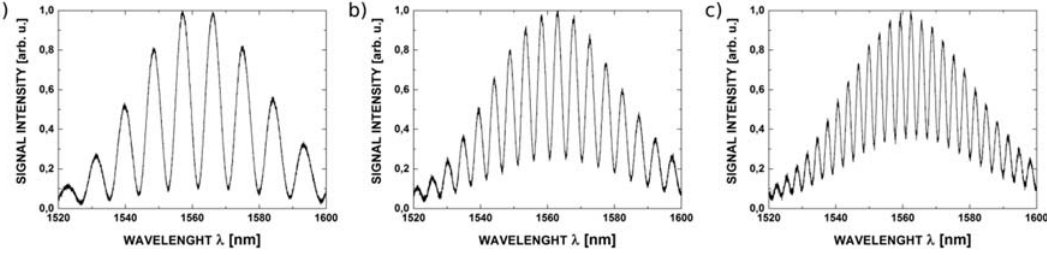
Figure 8. The measurement signal with the central wavelength 1550 nm for ZnO layer thickness of 200 nm and the length of Fabry-Pérot cavity: ( a ) 100 µm; ( b ) 200 µm and ( c ) 300 µm.